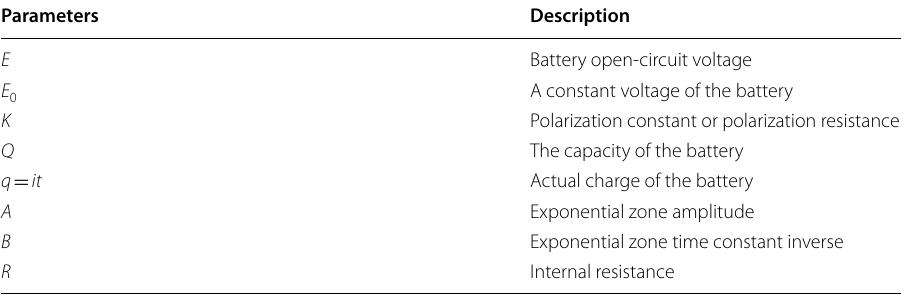
Table 5 Description of the parameters used in Eq. (4)